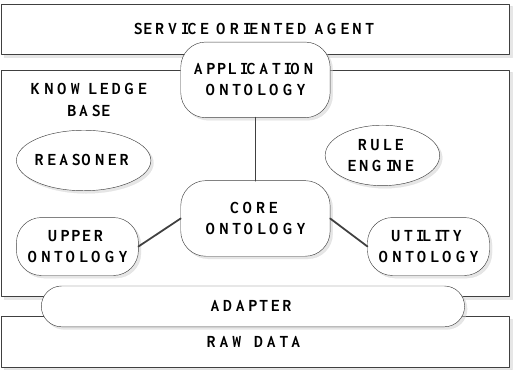
Figure 8. OODA loop for processing data, as described in [41].